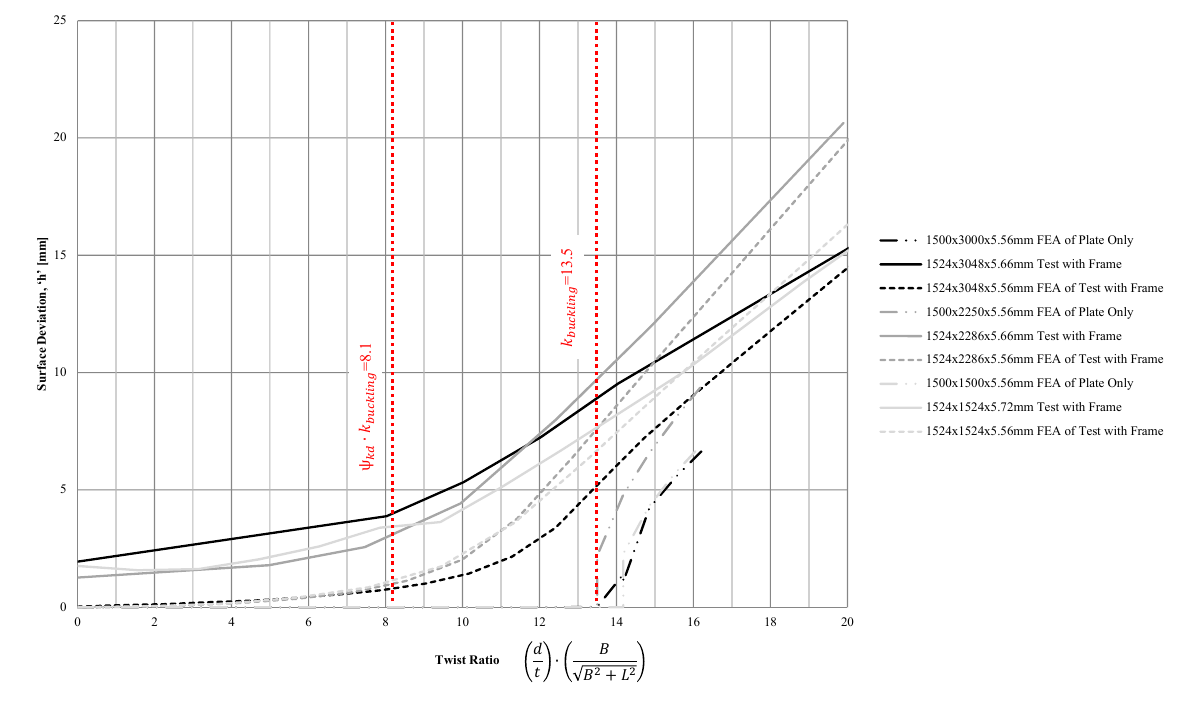
Fig. 10 Buckling Comparison to Previous Finite Element Analysis and Physical Tests at 5.56mm